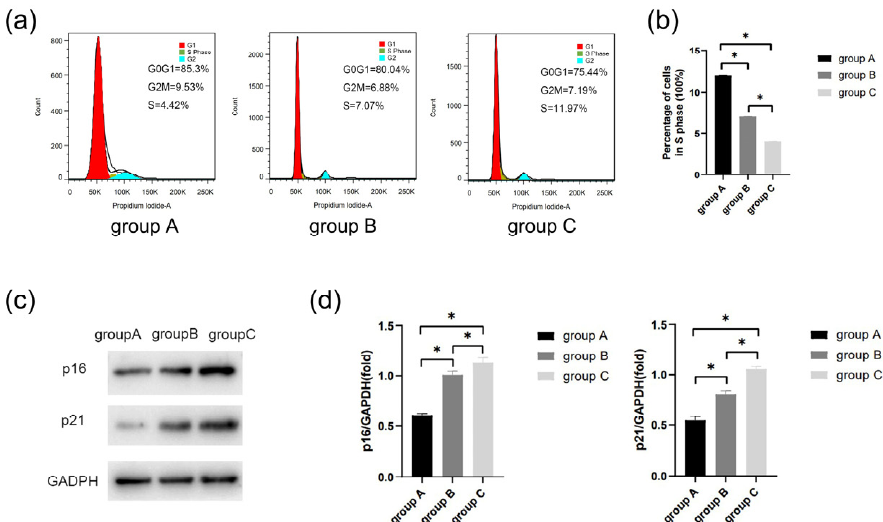
Figure 6. The cell senescence was determined by flow cytometric analysis and Western blot. ( a ) Cell cycle of each group was detected by flow cytometry. ( b ) Percentage of cells in S phase. ( c ) Protein expression of p21 and p16 in the three groups. ( d ) Quantitative analysis of p21 and p16 immunoblot. * p < 0.05.